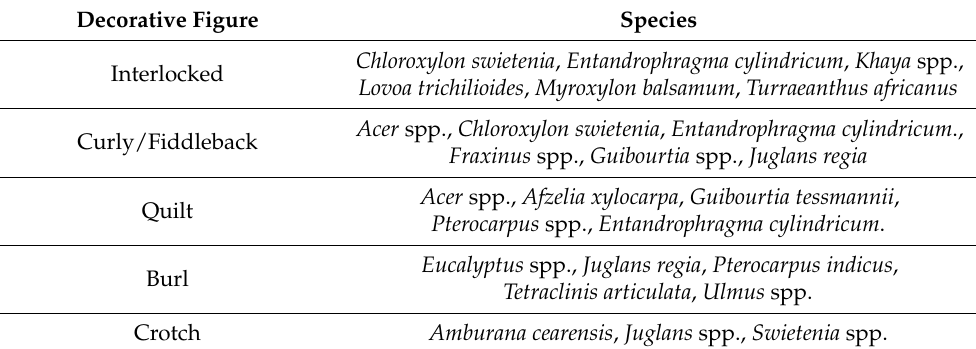
Table 15. Examples of species that may present decorative figures due to grain deviations.